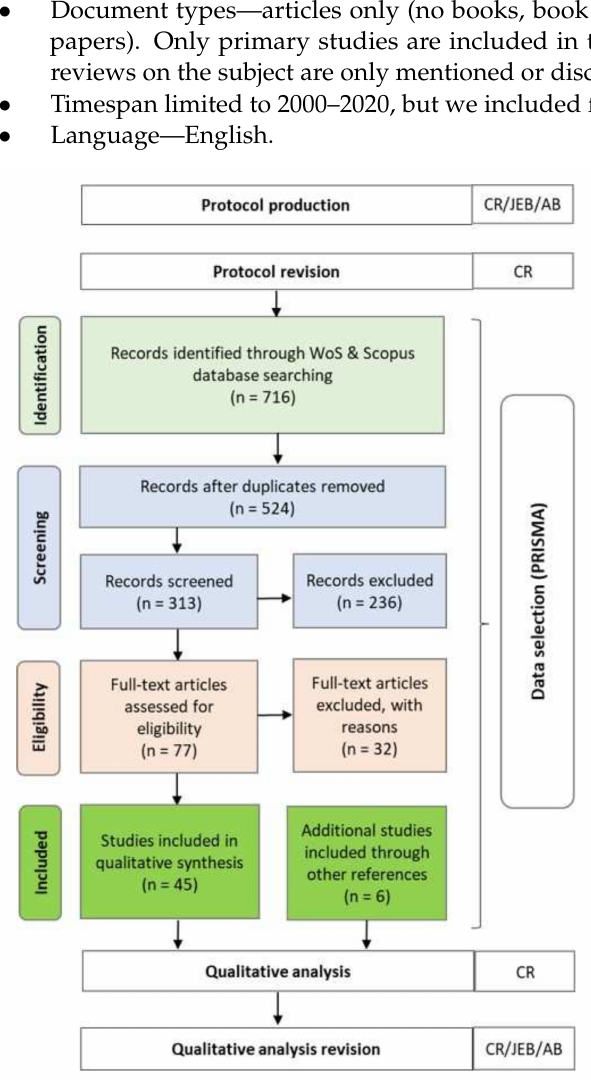
Figure 1. Data selection process—protocol based on PRISMA figure. Initials in the right column indicate the person(s) who performed the given